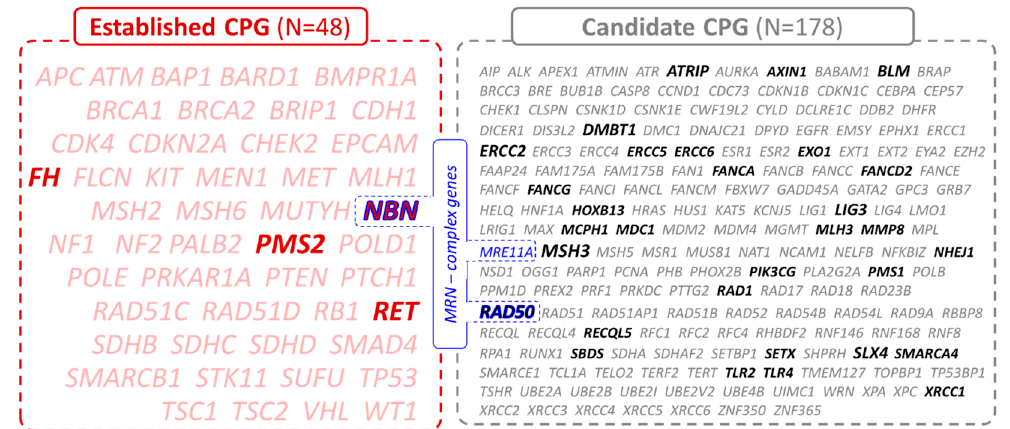
Figure 1. List of 226 cancer-predisposition genes divided into established (N = 48, in red) and candidate (N = 178, in grey) CPGs based on their clinical significance. The genes of the MRN complex are highlighted in blue. The PVs in CPGs highlighted in bold were found in this study.